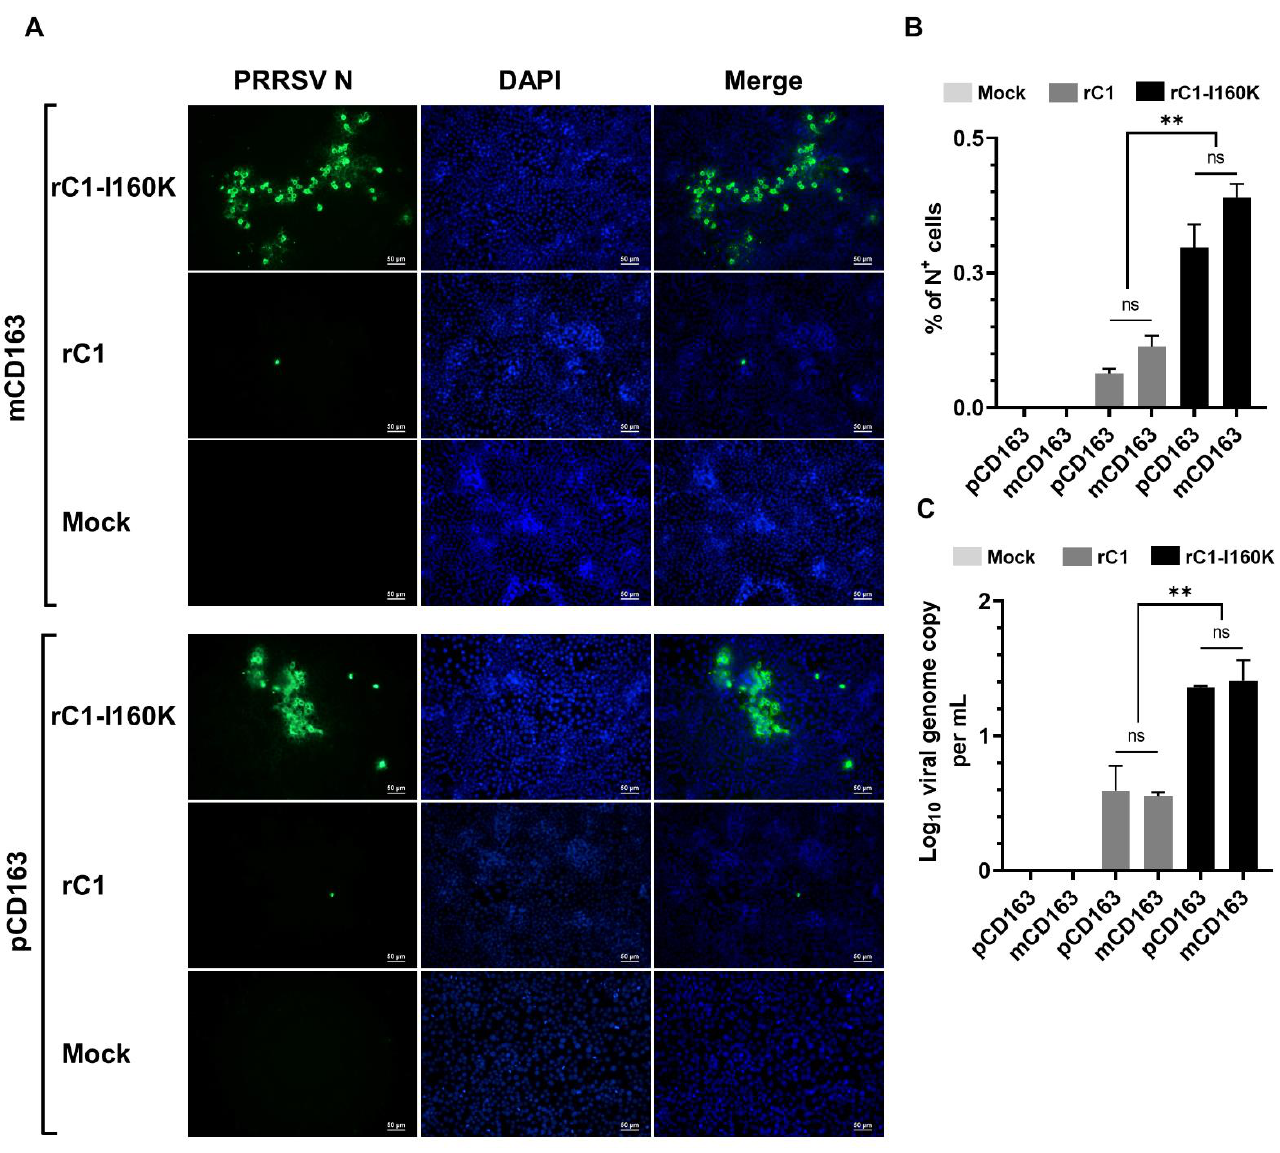
Figure 7. CD163 alone is not sufficient for rC1 infection. PK15 cells were transduced with lentivirus- expressing porcine (p) or monkey (m) CD163, followed by 4 passages in a selection medium to eliminate non-transduced cells. The cells were then inoculated with indicated viruses at an MOI of 10. Data were collected at 72 hpi. ( A ) Representative images of cells that were fixed and stained with an anti-N antibody to visualize virus-infected cells (green color). DAPI was used to stain the nuclei (blue color) . Scale bar = 50 μm. ( B ) Percentage of cells expressing N protein as quantified by flowcytometry. ( C ) Difference of viral genome copy numbers in the culture supernatants collected at 0 hpi and 72 hpi as quantified by RT-qPCR. Data are presented as means and SEM of the three independent experiments. ns: non-statistically significant, ** p < 0.01.